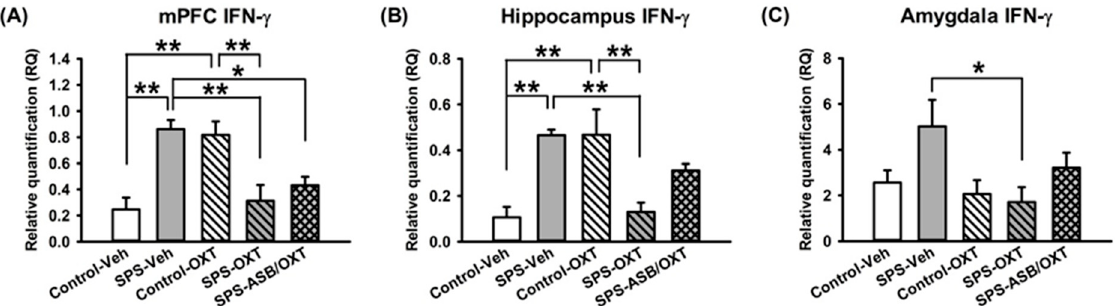
Figure 4. SPS changed the mRNA expression of central IFN- γ mRNA levels in a region-dependent manner, and OXT could reverse this phenomenon. IFN- γ levels in mPFC (medial prefrontal cortex) were increased following SPS, which could be reversed by OXT, and ASB was unable to block the OXT effect ( A ). Hippocampus IFN- γ levels were also increased following SPS, which could be reversed by OXT, and ASB further blocked the OXT effect ( B ). Amygdala IFN- γ levels seemed to be also increased following SPS, even though not significantly, which could be reversed by OXT, and ASB was unable to block the OXT effect ( C ). n = 5 for each group; SPS: single prolonged stress, Veh: vehicle, OXT: oxytocin, ASB: atosiban. Bars represent mean ± SEM; * p < 0.05, ** p < 0.01. For the TNF- α mRNA levels, our data exhibited that the SPS and drugs (OXT and ASB) were no